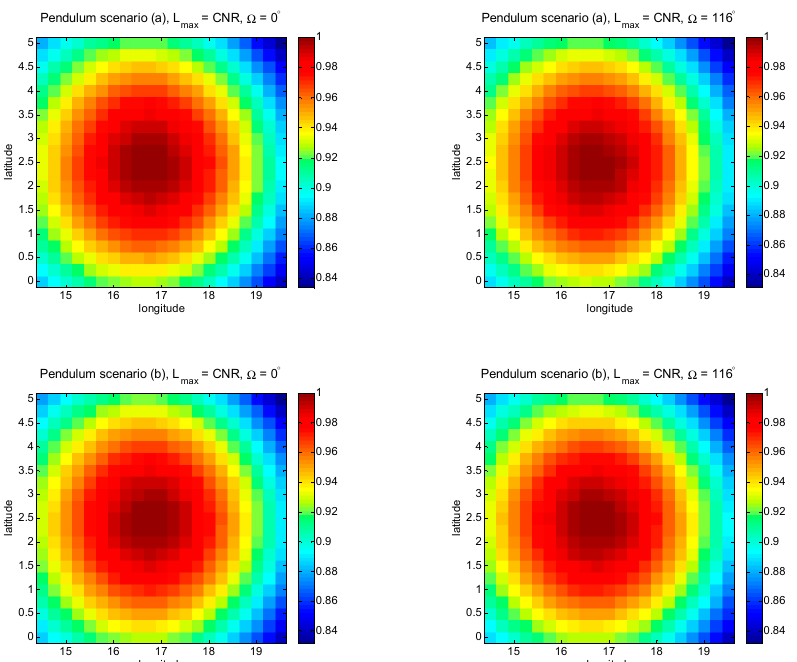
Figure 27. Spatial covariance of a selected point in West Africa (from Figures 19 and 20) for 6-day solution of the Pendulum formation up to L max = CNR, for top : scenario (a), and bottom : scenario (b). Left is Ω = 0° and right is Ω = 116°.